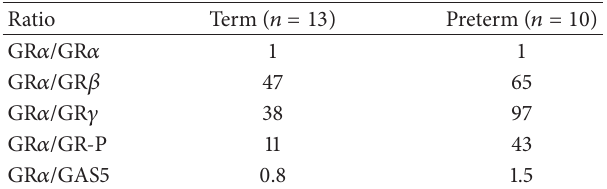
Table 2: Relative mRNA abundance of GR 𝛼 over GR 𝛽 , GR 𝛾 , GR-P, and